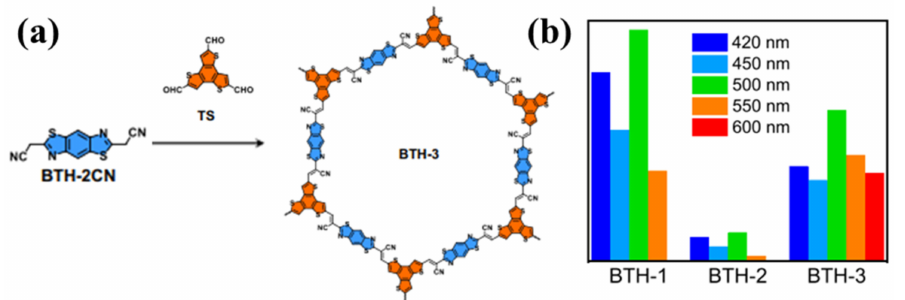
Figure 14. ( a ) Synthetic routes and chemical structures of COFs BTH-3. ( b ) AQY of BTH-1, 2, 3 under different monochromatic light irradiation. Reproduced with permission from Ref. [58]. Copyright: Nature,